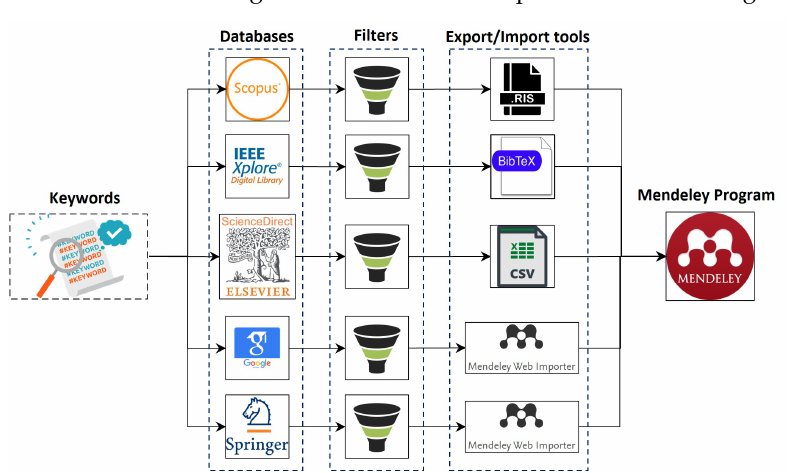
Figure 4. The steps and tools for conducting the SLR